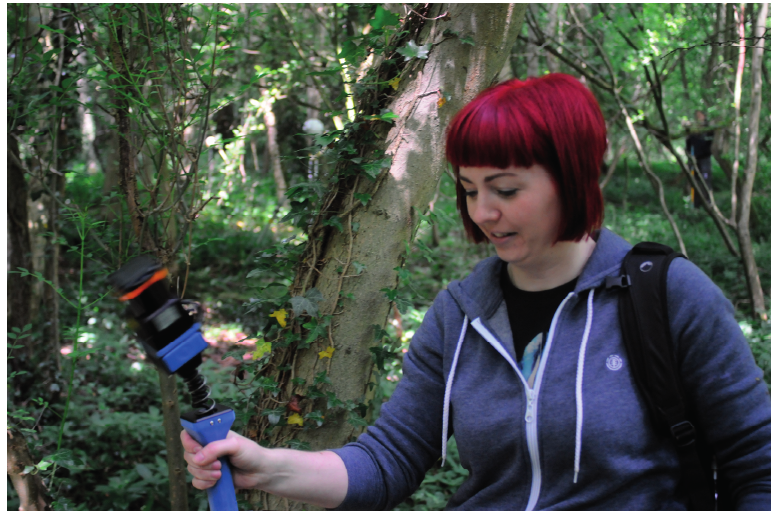
Figure 1. ZEB1 handheld mobile laser scanner in operation for forest